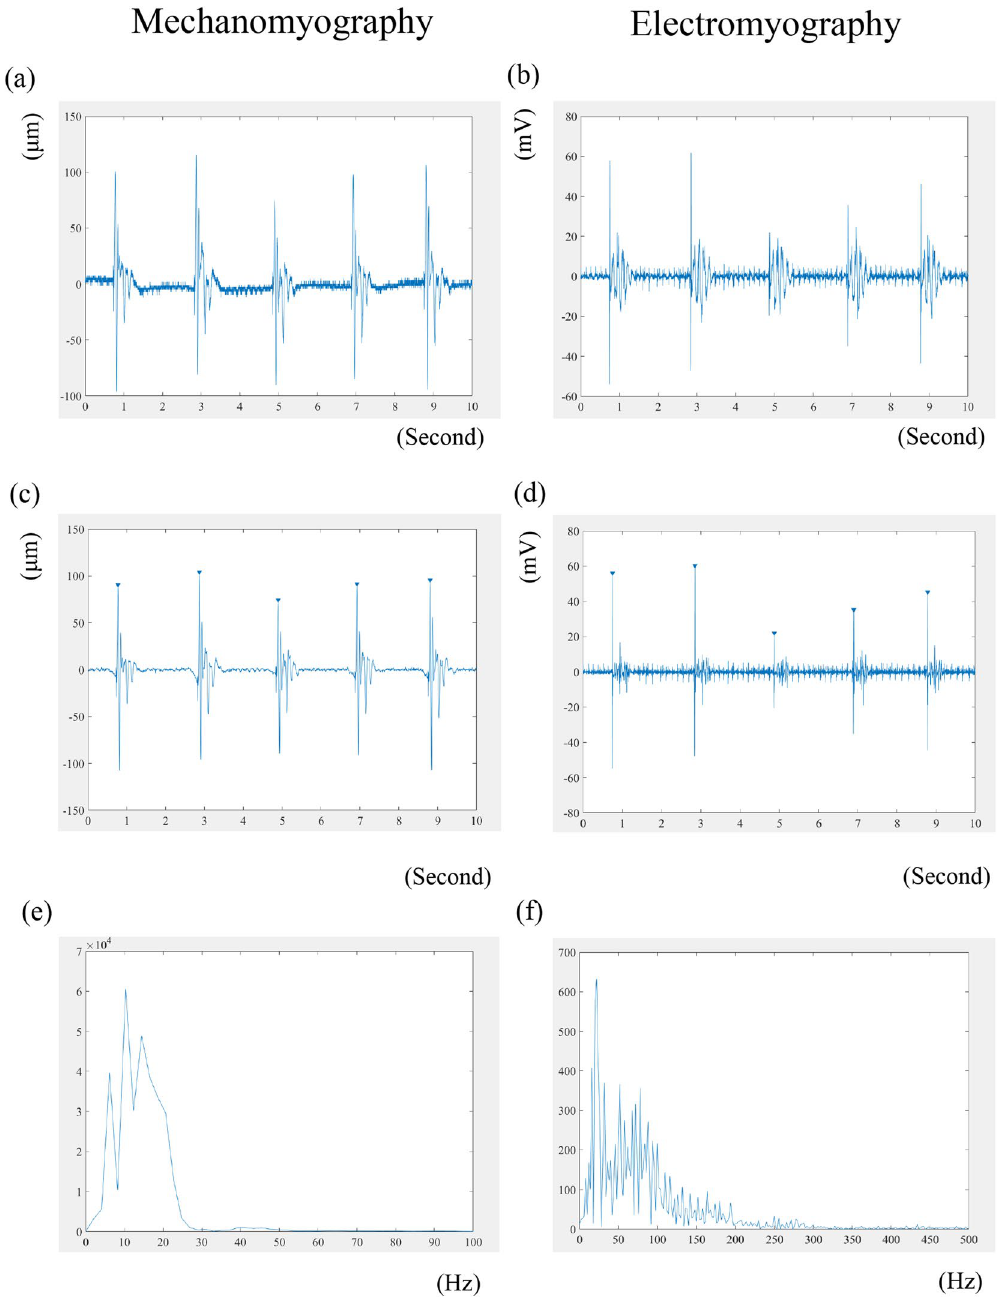
Figure 5. Wave analyses. Typical raw waveform for MMG ( a ) and EMG ( b ). Filtering and peak detection for MMG ( c ) and EMG ( d ). An inverted triangle is shown on each peak waveform, and a point 0.5 ms after each peak was selected; subsequently, RMS was evaluated. MPF was evaluated using a fast Fourier transformation algorithm for MMG ( e ) and EMG ( f ). MMG, mechanomyography; EMG, electromyography; RMS, root mean square; MPF, mean power